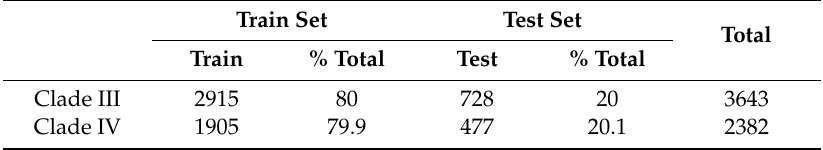
Table 8. Summary of the five di ff erent training and test sets related to SOM obtained with diterpenes from clades III (Nep) and IV (Aju, Lam and Scu).